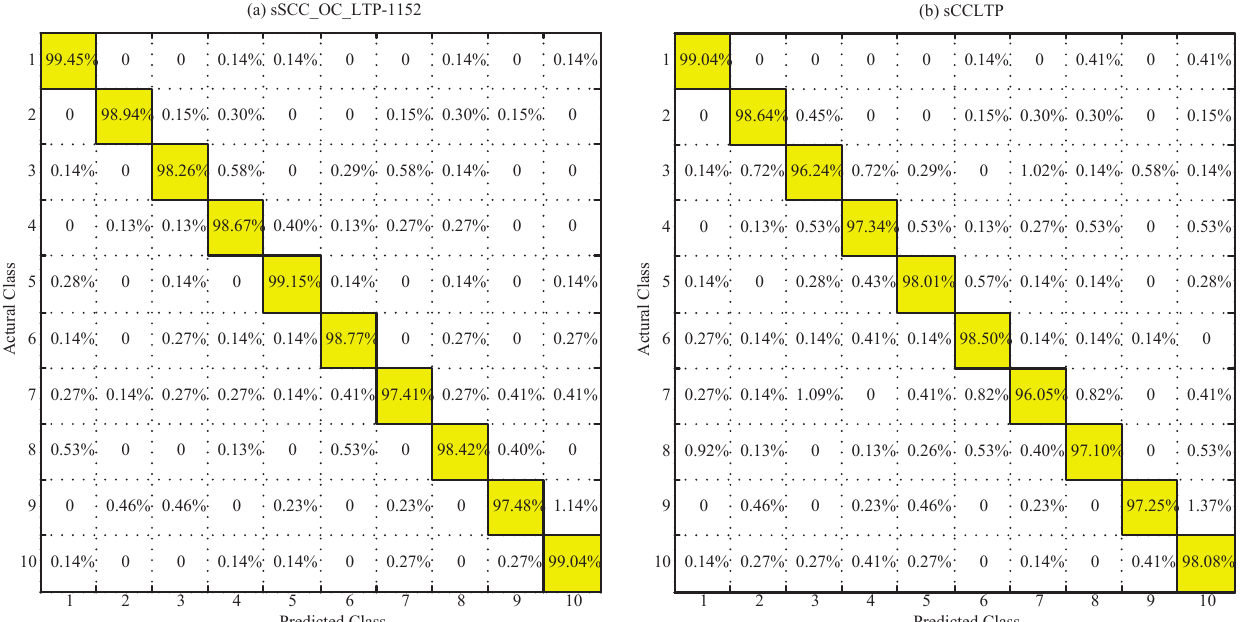
Figure 10. Confusion matrices of the sSCC_OC_RLTP and